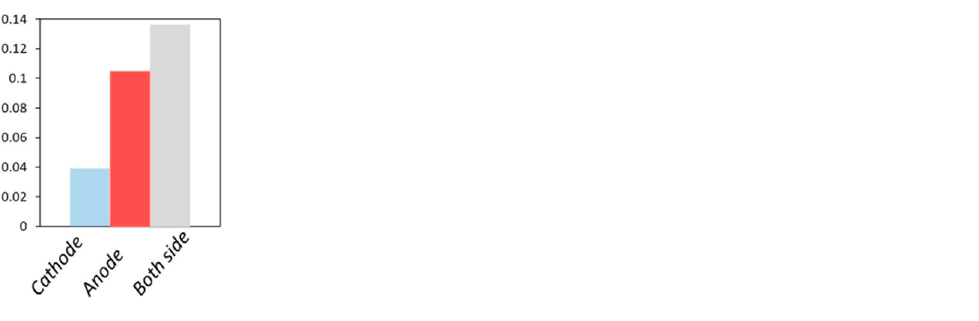
Figure 40. Voltage change due to light irradiation onto the cathodic side only, anodic side only, and both sides. Reprinted from [52]. Copyright 2020 by John Wiley & Sons, Inc.